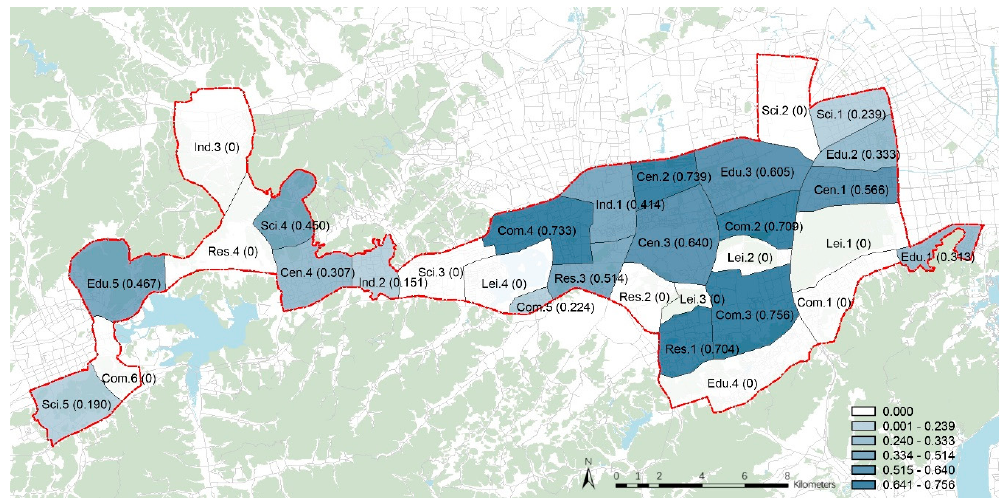
Figure 5. Employee Balance Index of each area in the Corridor.